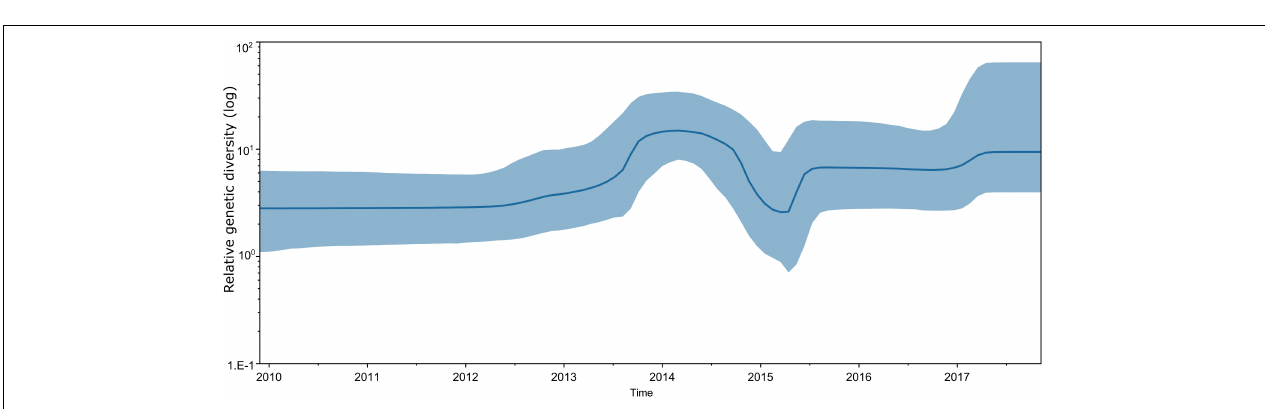
(T. A. Nguyen et al., 2018), 7.42 × 10 − 3 substitutions per